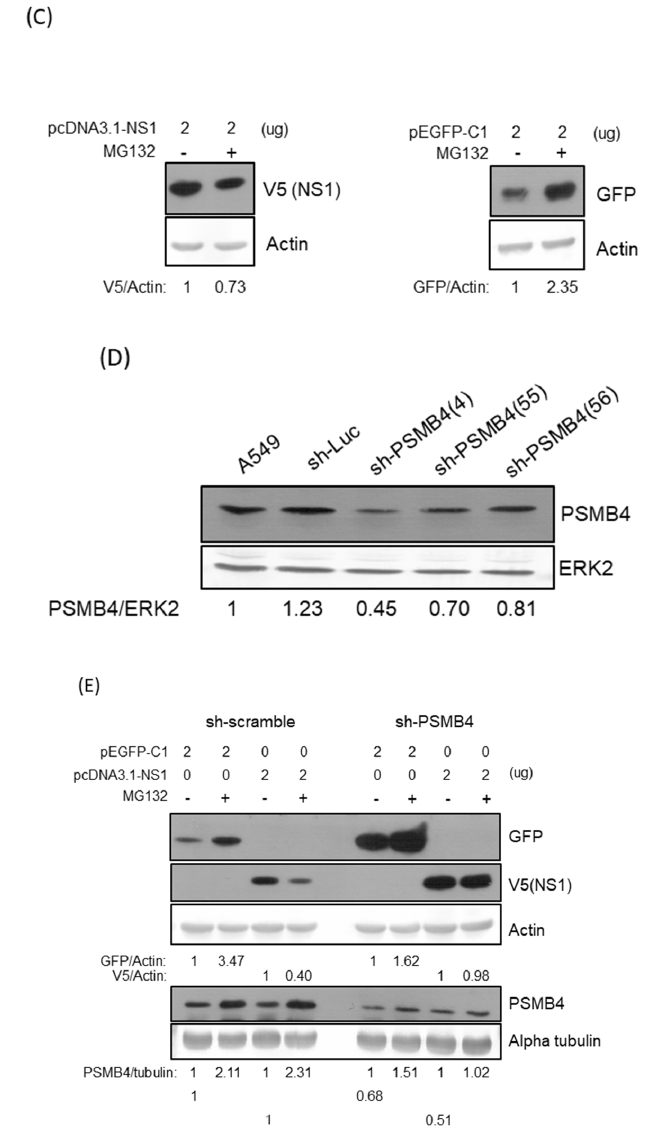
Figure 5. ( A ) Transiently co-transfected PSMB4 inhibited NS1 protein expression dose-dependently (right panel) but not GFP expression (left panel). Cell lysates from A549 cells transfected with different combinations of plasmids as indicated were analyzed by SDS-PAGE and Western blotting against GFP, against V5 (for exogenous NS1), HA tag (for exogenous PSMB4). Actin was used as the loading control (bottom panel). ( B ) Transiently co-transfected PSMB4 reduced NS1 protein expression (lower panel) but not that of GFP or IAV M1 protein (upper panel) in the presence of MG132. Cell lysates from A549 cells transfected with different combinations of plasmids as indicated and treated without or with 10 uM MG132 were analyzed by SDS-PAGE and Western blotting as indicated. ( C ) MG132 prevented GFP but facilitated NS1 protein degradation. Cell lysates from A549 cells transfected with plasmids encoding NS1 or GFP as indicated and treated with 10 uM MG132 or not were analyzed by SDS-PAGE and Western blotting as indicated. ( D ) Knockdown efficiency of various shRNAs targeting PSMB4. Cell lysates from A549 cells transduced with the lentiviral vectors expressing shRNAs targeting Luc (as the control) or PSMB4 (different clones) and selected with puromycin were analyzed by SDS-PAGE and Western blotting against PSMB4 or ERK2. ( E ) MG132 did not facilitate NS1 protein degradation in the cells with shRNA targeting PSMB4. Cell lysates from A549 cells with shRNAs targeting Luc or PSMB4 transfected with plasmids encoding NS1 or GFP in the presence of 10 uM MG132 or not were analyzed by SDS-PAGE and Western